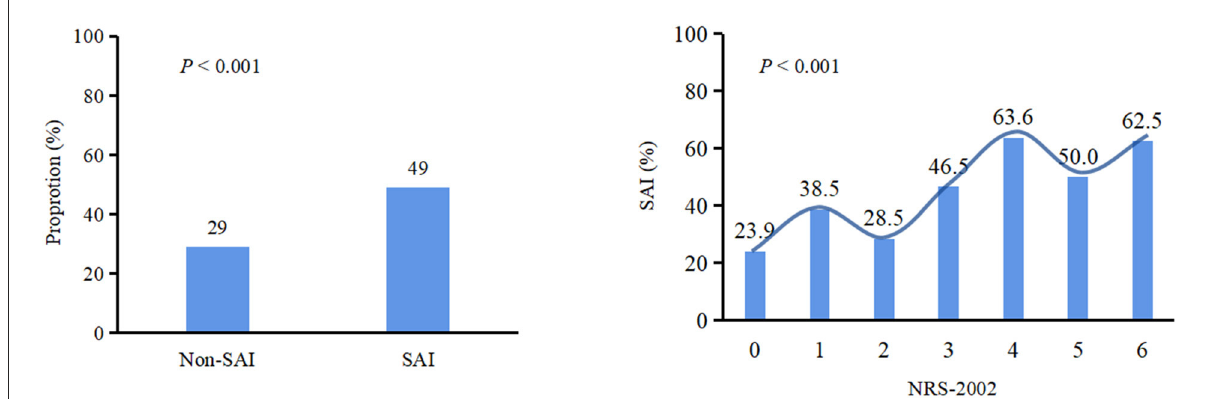
FIGURE1 Chi square test was used to compare categorical variables. The proportion of patients with malnutrition (NRS-2002 ≥ 3) in SAI is higher than that in non-SAI ( P < 0.001). Patients with NRS-2002 score ≥ 3 were more likely to develop SAI ( P < 0.001). SAI, Stroke-associated infection;NRS-2002, Nutritional Risk Screening 2002.